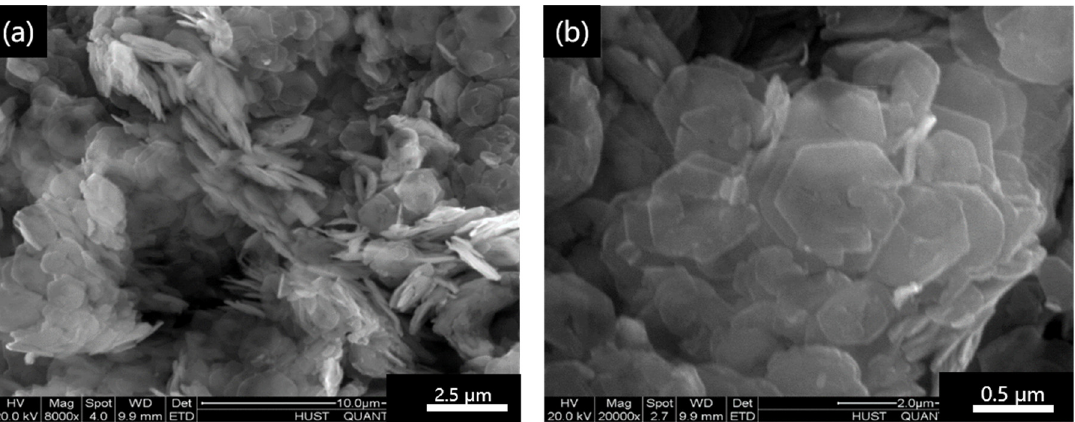
Figure 1 . Characterization of the microstructure of the FeMgAl-MoS 4 material. SEM images with magnification factors of 2.5 μ m ( a ), and 0.5 μ m ( b ) . magnification factors of 2.5 µ m ( a ), and 0.5 µ m ( b